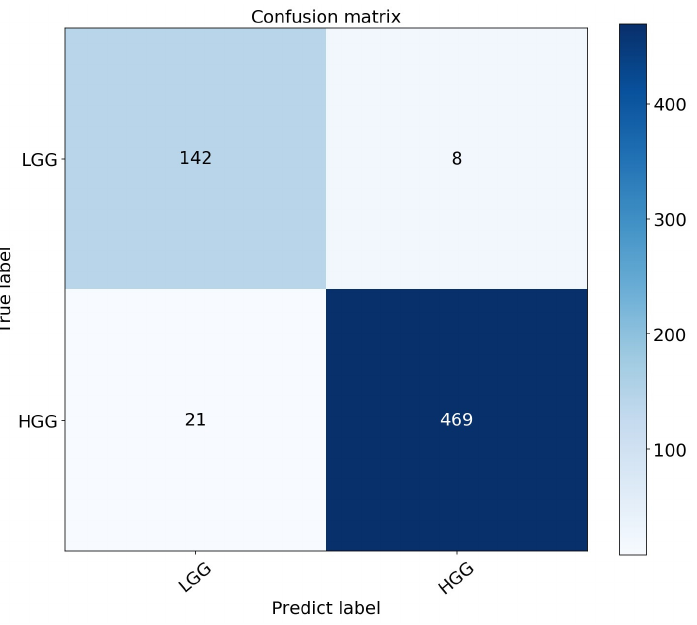
Figure 5. Confusion matrix of HGG and LGG.